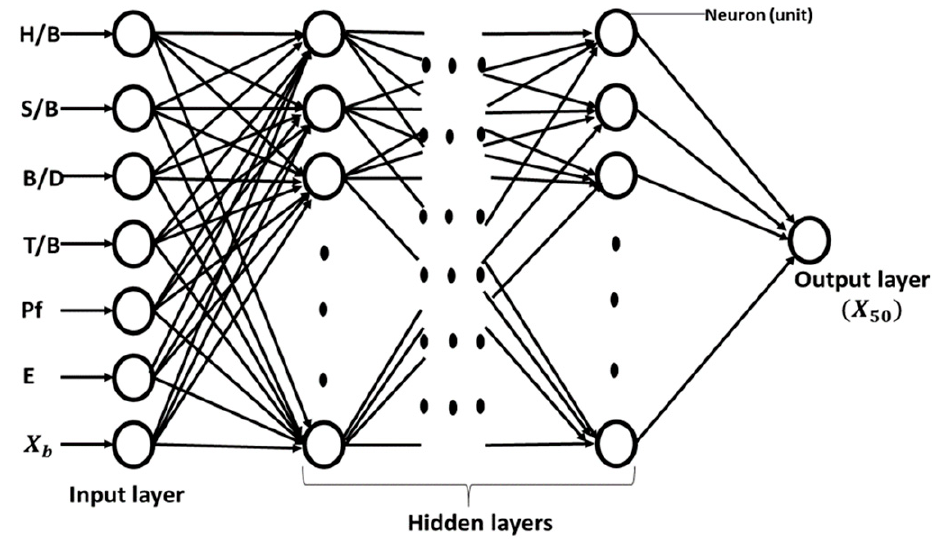
Figure 4. ANN architecture for rock fragmentation prediction.